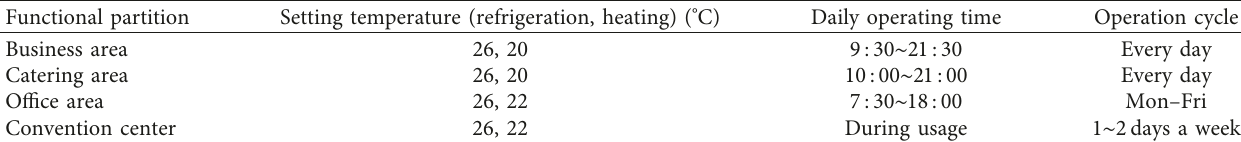
Table 2: System operation during the refrigeration and heating periods.